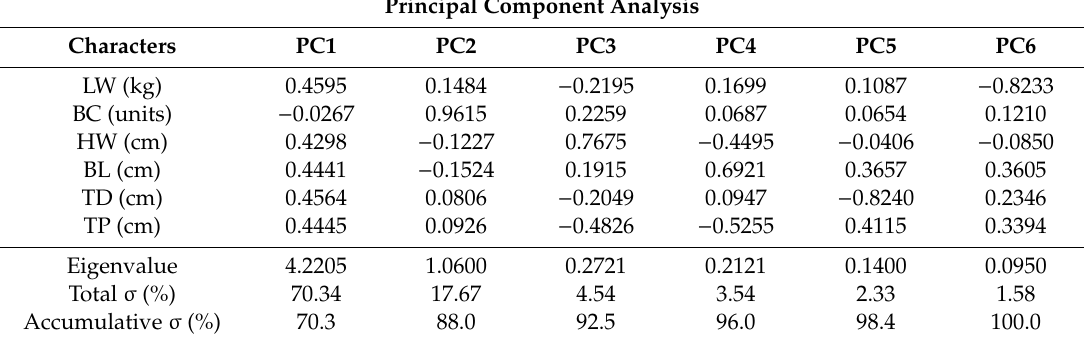
Table 4. Principal component analysis of morphometric variables considering the live weight (LW, kg), body condition score (BC, units), height at the withers (HW, cm), body length (BL, cm), thoracic diameter (TD, cm), thoracic perimeter (TP, cm), eigenvalues, total variance ( σ , %), accumulative variance ( σ , %) in crossbred (Alpine-Saanen-Nubian x Criollo; n = 70) dairy goats managed under intensive conditions in Northern Mexico (March, 25 ◦